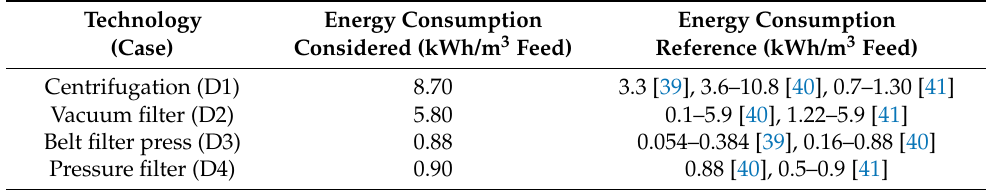
Table 1. Energy requirement in second stage of